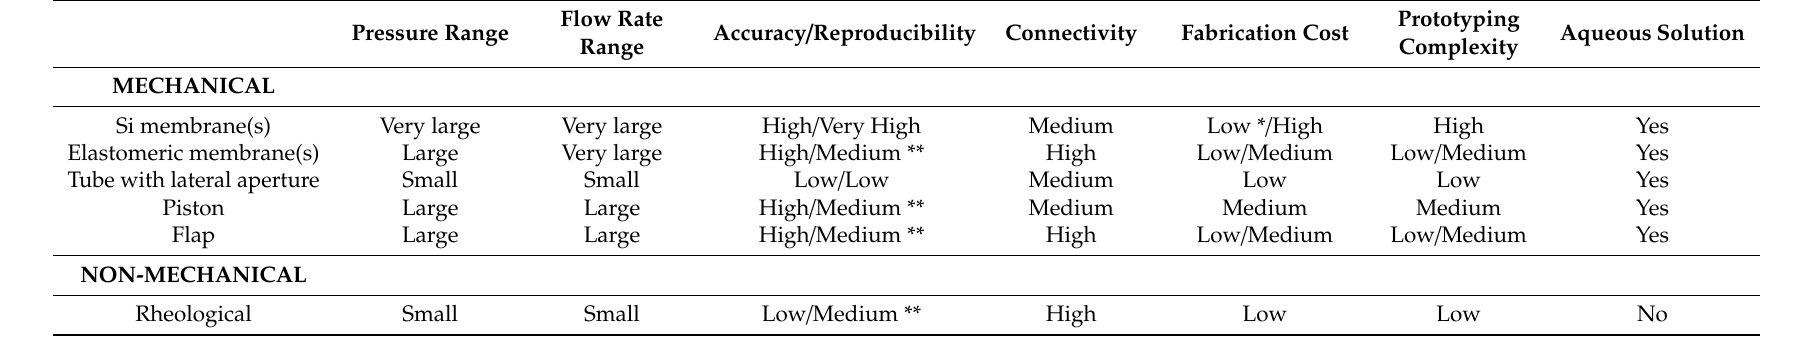
Table 2. Comparative table of the di ff erent categories of passive constant flow